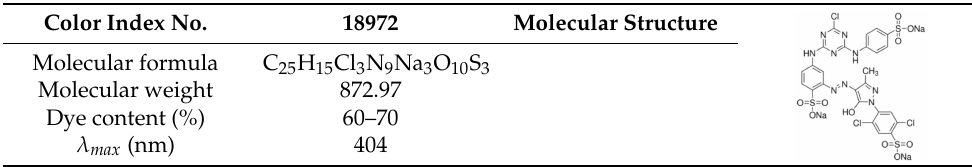
Table 5. General characteristics of Reactive Yellow